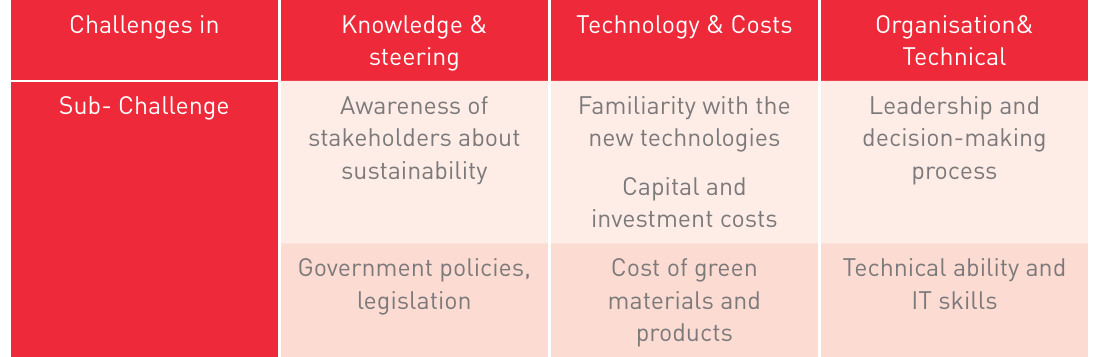
Table 5. The categorisation of the factors into challenges Challenges